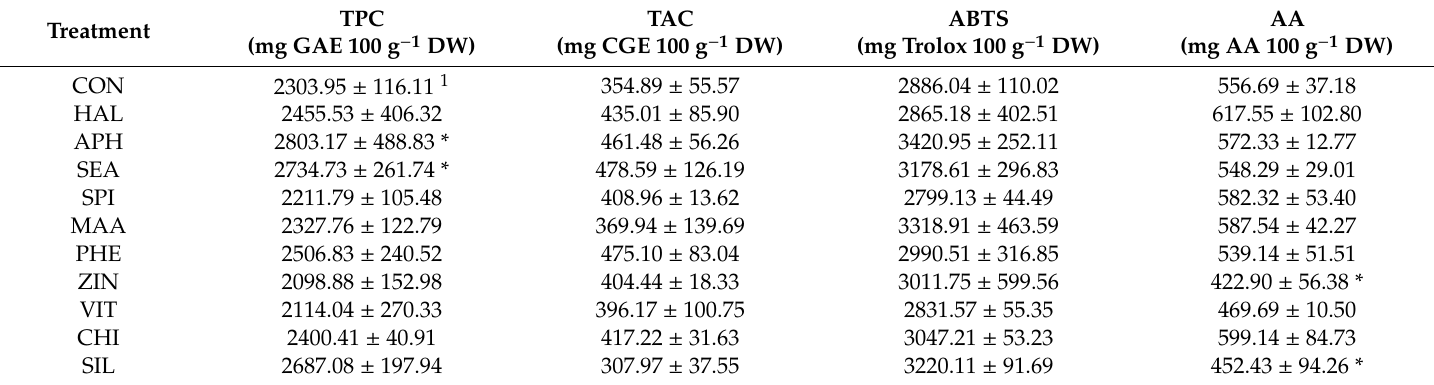
Table 11. Fruit nutraceutical values (TPC—total phenolic content; TAC—total anthocyanin content; ABTS—antioxidant potential; AA—ascorbic acid) as a ff ected by biostimulant